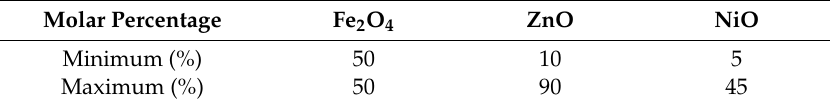
Table 4. Material molar composition percentage of NiZn soft